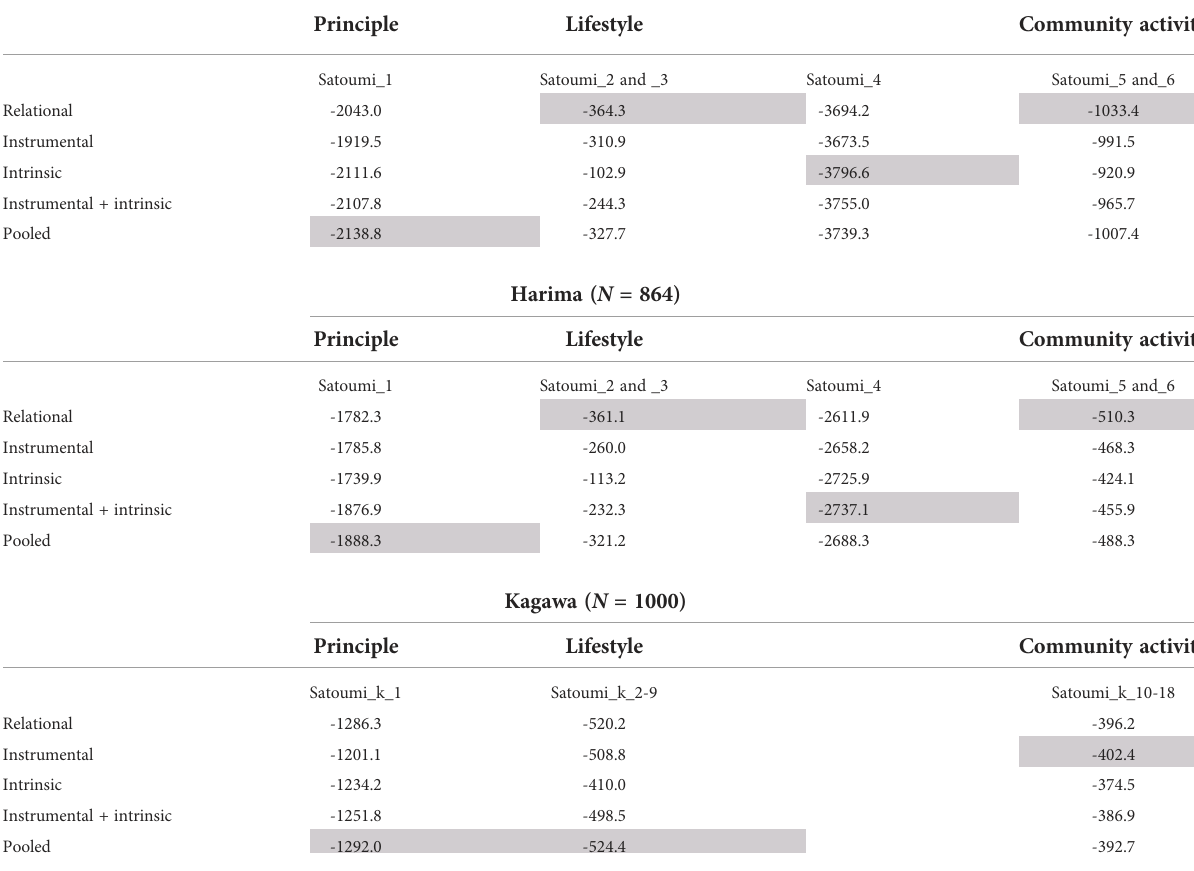
TABLE 8 BIC for beta regression models by